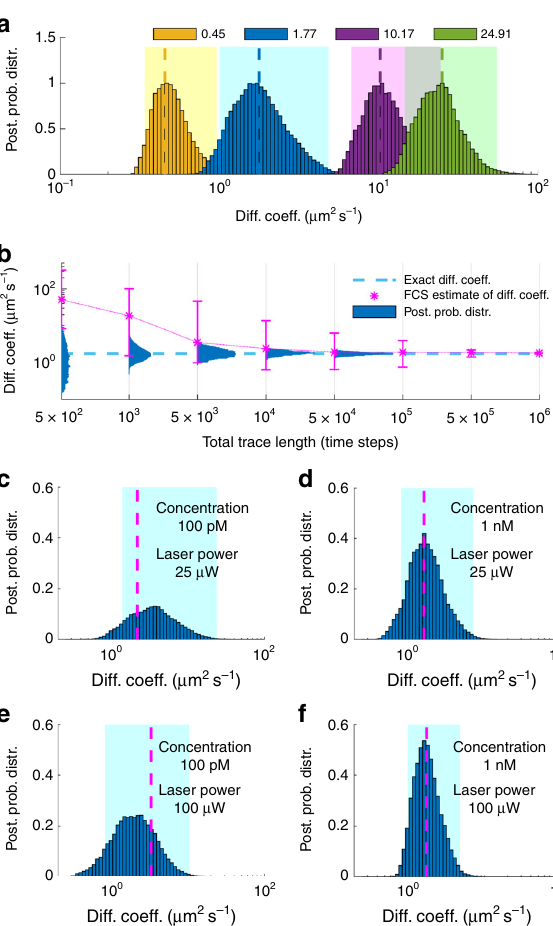
Fig. 5 Estimating diffusion coef fi cients of free Cy3. a Posterior probability distributions of diffusion coef fi cients of free Cy3 in different concentrations of glycerol/water mixture. The legend labels the posteriors according to FCS estimates of long time traces. For clarity, posteriors are normalized to maximum 1 and the horizontal axis is shown in logarithmic scale. Also, the 95% con fi dence intervals are shown by highlighted regions. Posteriors are obtained from the analyses of time traces acquired at 100 μ s for total periods of 100 ms. Different diffusion coef fi cients are obtained by varying the amount of glycerol from 99 to 50% in the glycerol/water mixture. b Posterior probability distributions deduced from traces acquired at 100 μ s with total trace lengths of 5 × 10 2 , 1 × 10 3 , 5 × 10 3 , 1 × 10 4 , and 5 × 10 4 time steps. For the sake of comparison, exact values and FCS estimates are also shown and, for clarity, the vertical axis is shown in logarithmic scale. Error bars in the FCS curve are produced by analyzing multiple windows in the initial trace. To estimate the diffusion coef fi cient within less than a factor of 2 of the true value, it is typical for FCS to require ≈ 50 × more data than our method. c – f Posterior probability distributions over the diffusion coef fi cients of traces generated by different laser powers (25 and 100 μ W, respectively) with different concentrations of Cy3 (100 p M and 1 n M , respectively) in a glycerol/water mixture of 94% glycerol. For the sake of comparison, FCS estimates, shown with dashed lines, are obtained from traces each 6 min